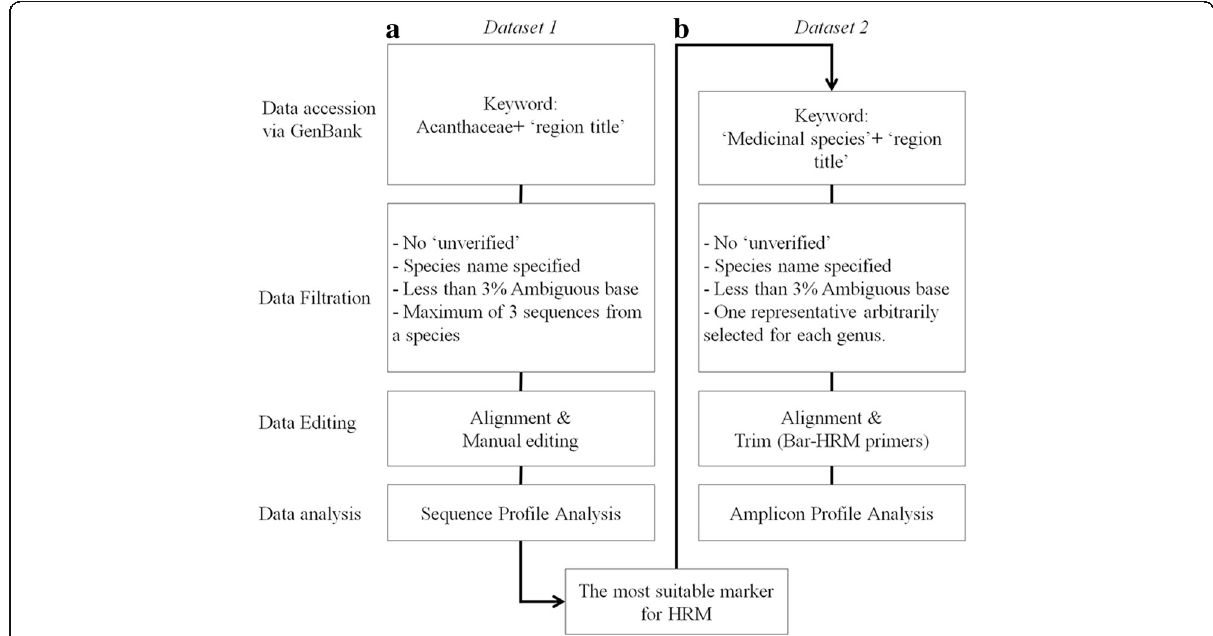
Fig. 1 Workflow of data accession and in silico analysis to address the most suitable DNA barcode for Bar-HRM of medicinal Acanthaceae. a . Dataset 1 , DNA barcodes retrieved from GenBank of the entire family Acanthaceae were included. b . Dataset 2 , the best performed barcode of only medicinal species of Acanthaceae were included in